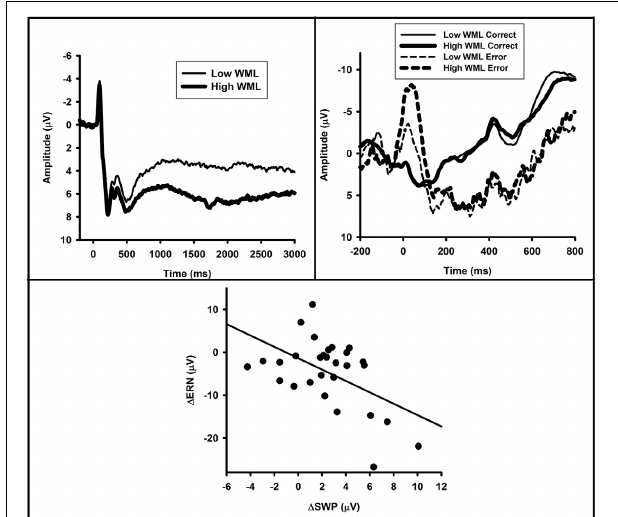
FIGURE 6 | Working memory load enhances ERN. (Top Left) SWPs elicited during the memory retention interval. (Top Right) Response-locked ERPs as a function of accuracy and WML. (Bottom) A scatterplot depicting the association between WM-related changes in SWPs and ERNs.